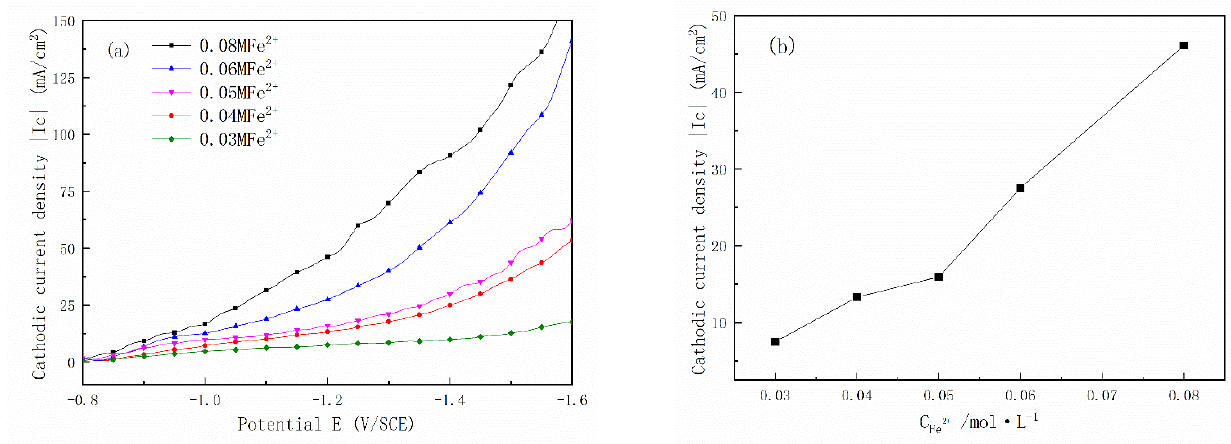
Figure 2. ( a ) Cathodic polarization curves measured in solutions with different Fe 2+ concentrations; ( b ) the corresponding cathodic current density |Ic| at a potential of − 1.2 V.